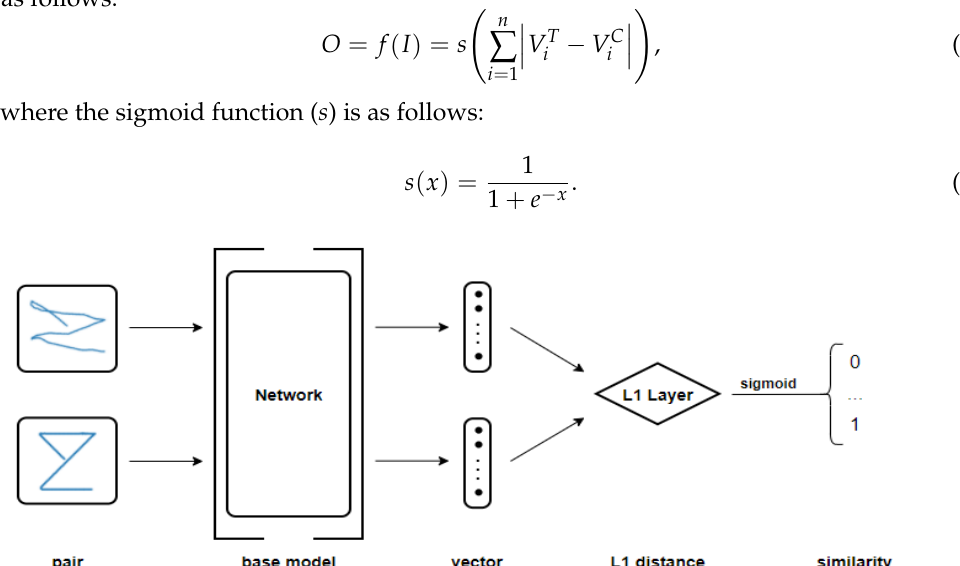
Figure 6. Siamese network structure. The input data of the network is a pair of two eye-written characters: one is a target data to recognize and the other is a comparative character. The base model consists of two networks that share a network structure and weights. The outputs of the base model are two feature vectors from the two input characters. The output of the whole network is calculated by employing L1 distance and sigmoid functions with the feature vectors.